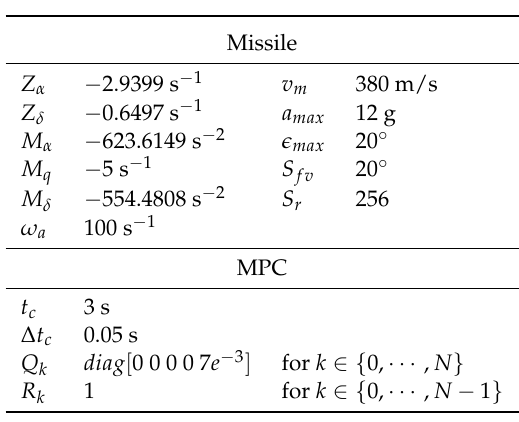
Table 1. Parameters of the missile and its